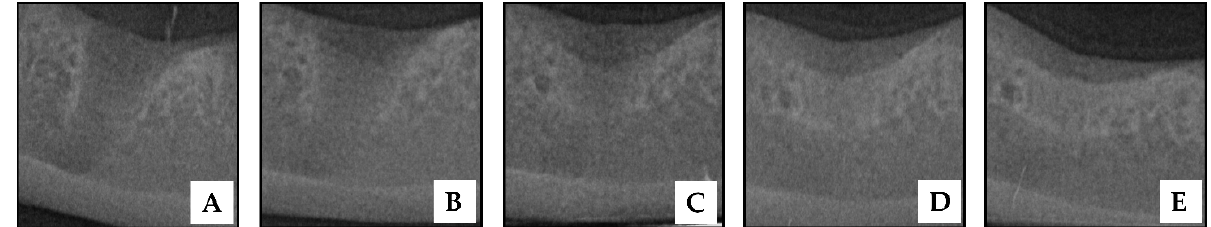
Figure 7. Intraoral radiographs of first mandibular molar socket after nanohydroxyapatite-based hydrogel placement in different weeks of postoperative follow-up including the day of operation ( A ), 2nd week ( B ), 4th week ( C ), 8th week ( D ), 12th week ( E ) after operation.